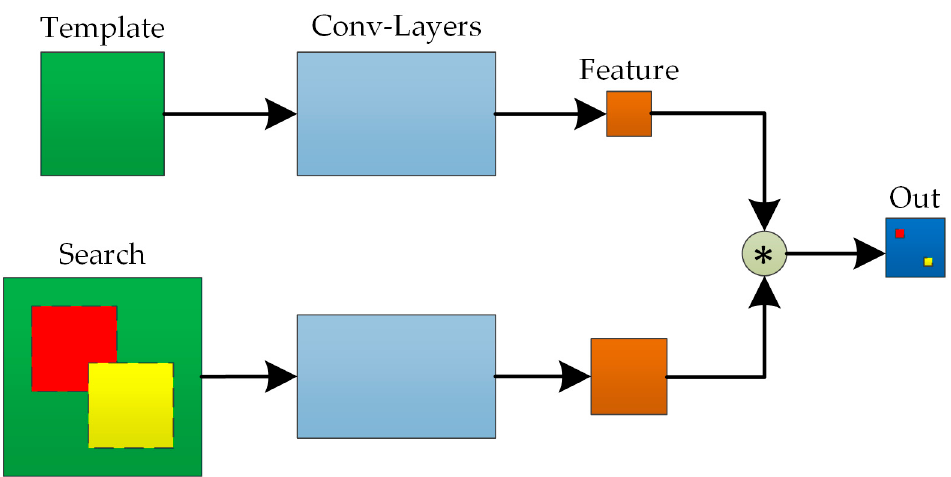
Figure 1. The network structure of the Siam-FC network.